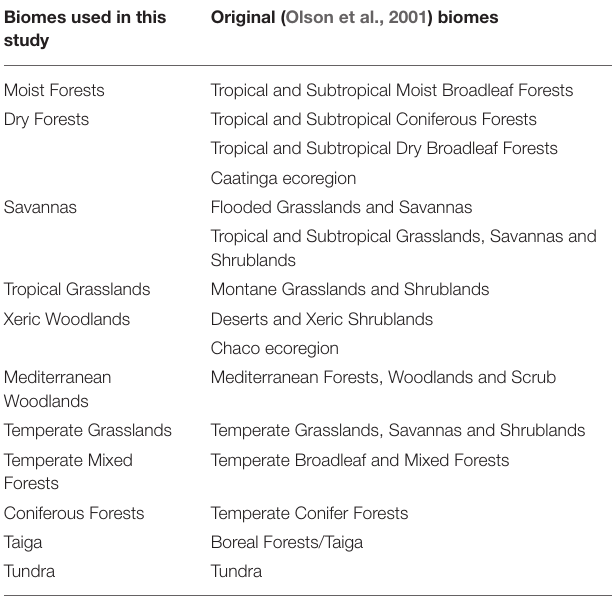
TABLE 1 | Overview of the biome classification adopted in this study and the equivalent (Olson et al., 2001) biomes classification (excluding Inland Water, Rock and Ice, and